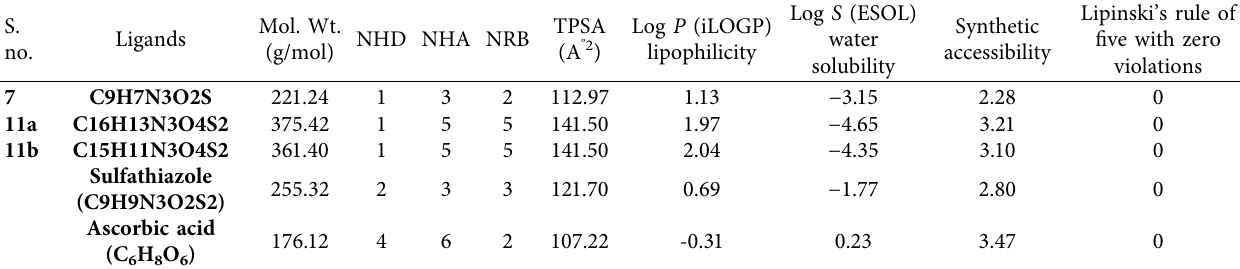
Table 5: Drug likeness predictions of compounds, computed by SwissADME.